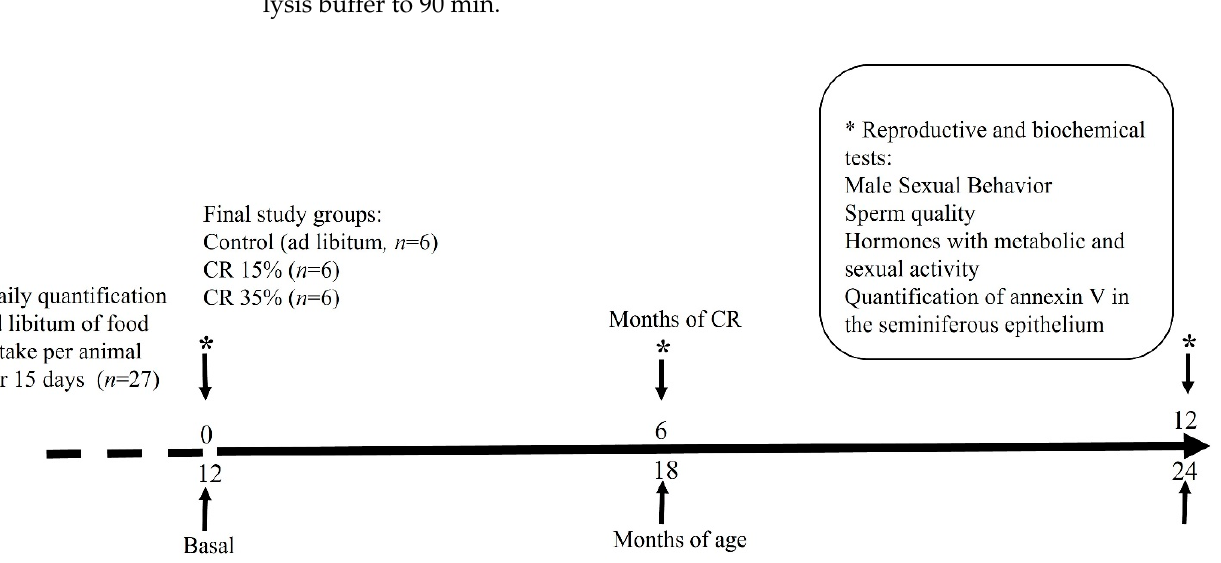
Figure 1. Timeline of the experimental design. Food intake ad libitum per animal was recorded for 15 days before CR (discontinuous line). The experiment began when the rats reached 12 months old (basal 0) with three groups: control (food ad libitum), CR at 15%, and CR at 35% ( n = 6 for each group, final study). Reproductive and biochemical tests were performed (*) at baseline and 6 and 12 months of CR.